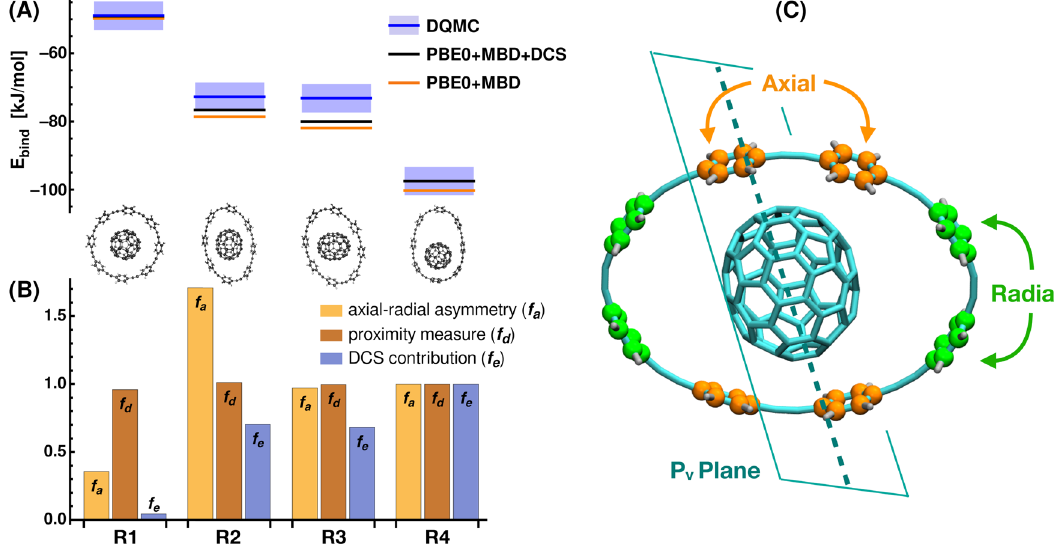
Fig. 3 Dipole-correlated Coulomb singles (DCS) contributions to binding energies of ring – C 70 complexes and correlation to structural features. A Binding energies for four ring – C 70 host – guest complexes (R1 – R4): PBE0 + MBD results (orange), diffusion quantum Monte-Carlo reference (DQMC, blue line; error bars as boxes), PBE0 + MBD including DCS (black line). DQMC reference data taken from ref. 16 . The hosts for R1 – R4 are 8-CPPA rings. B Measure of axial – radial asymmetry ( f a ), proximity measure ( f d ), and DCS contribution ( f e ) to binding energy (all values normalized to results for R4). De fi nition of axial and radial phenyl units of 8-CPPA via P v plane shown in C